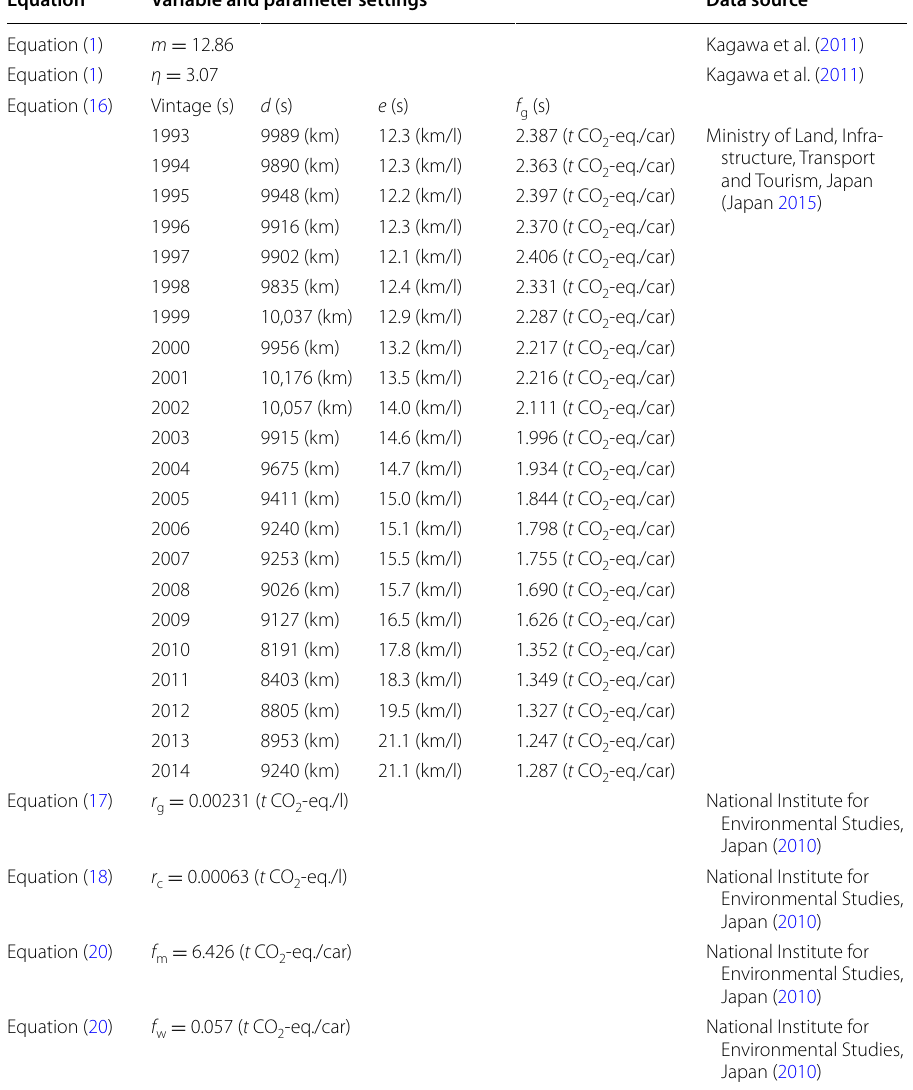
Table 1 Parameter settings used in this analysis Equation Variable and parameter